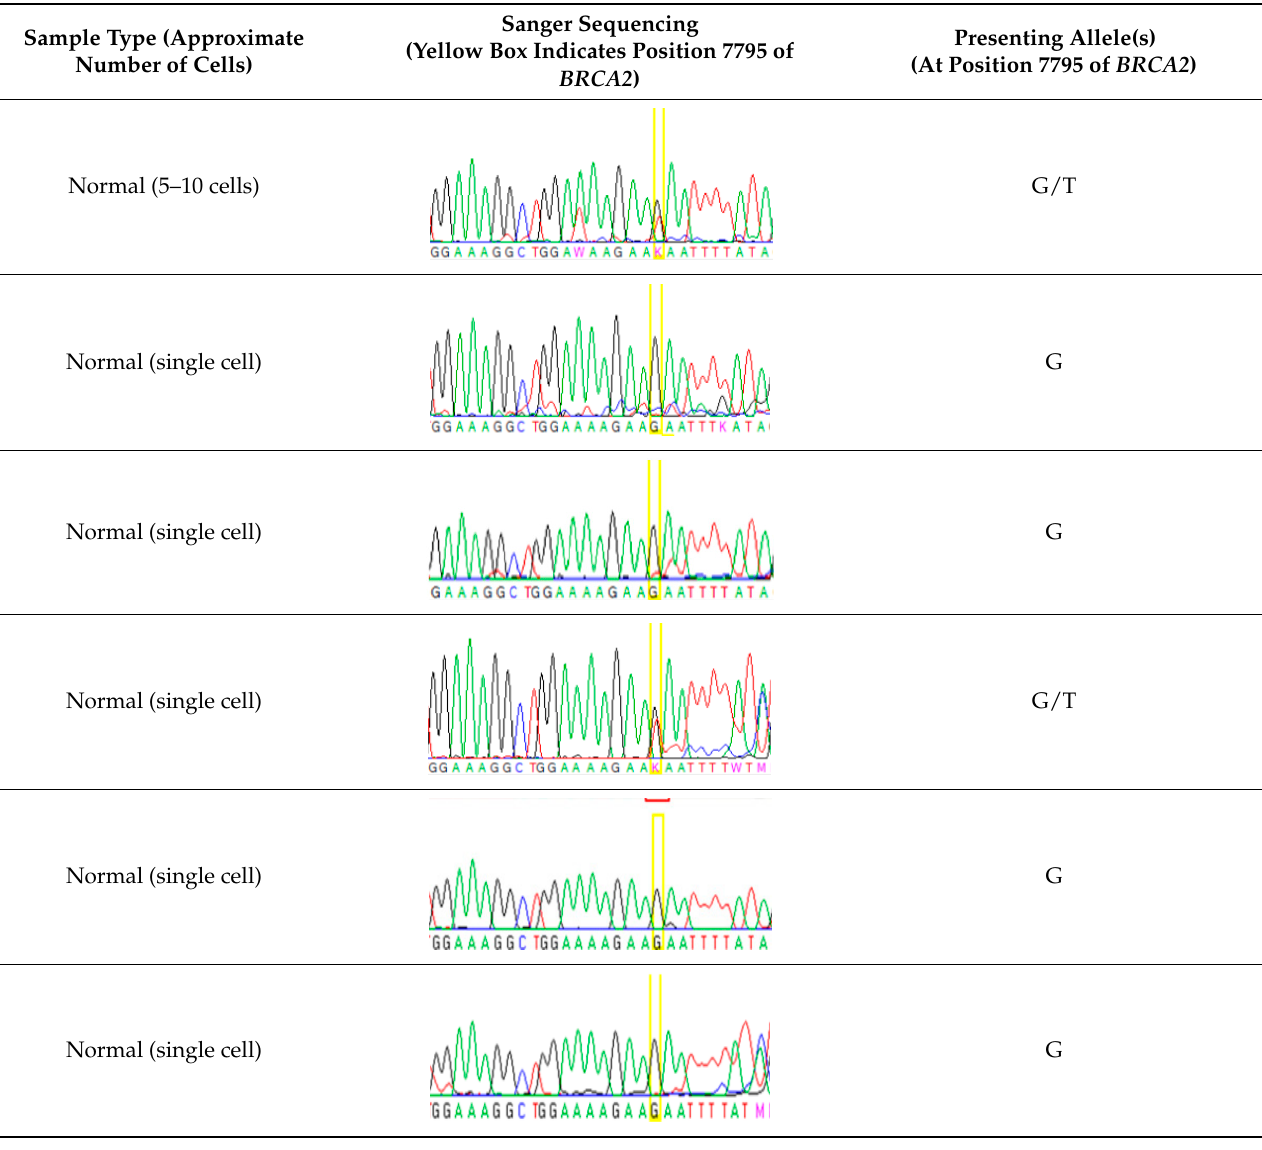
Normal (5–10 cells)